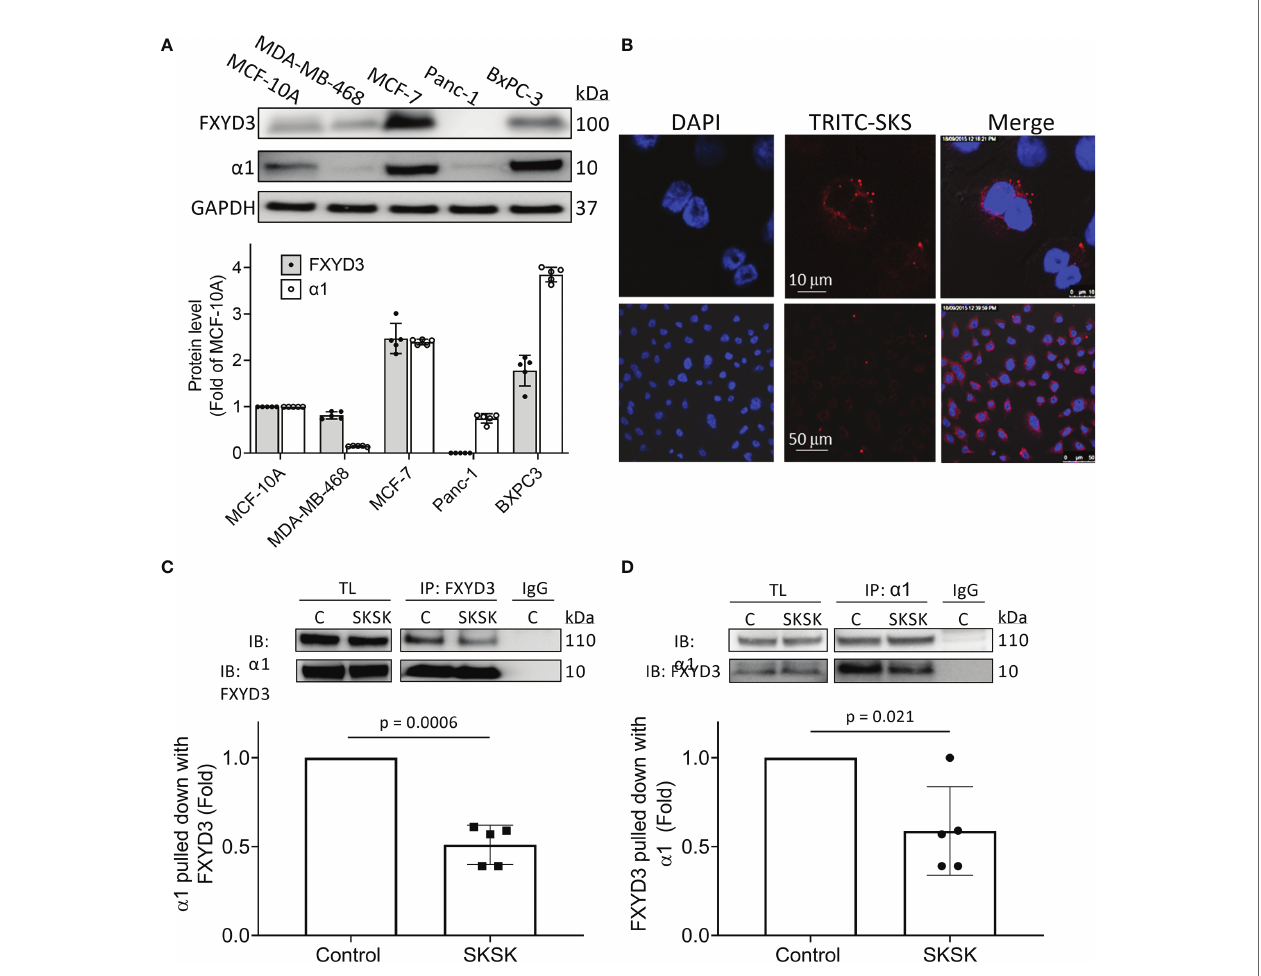
FIGURE 3 | Distribution of FXYD3-pep SKSK and its ability to displace FXYD3 from the a 1 Na + /K + -ATPase subunit. (A) FXYD3 and Na + /K + -ATPase a 1 subunit expression in MCF-7 and MDA-MB-468 breast cancer cells and in BxPC-3 and Panc-1 pancreatic cancer cells. Expression is normalized to expression in human non-cancer MCF-10A cells; GAPDH was the internal loading control. (B) Immuno fl uorescence showing distribution of TRITC-labeled FXYD3-pep SKSK in BxPC-3 cells. Cells were exposed to 1 µM TRITC-tagged FXYD3-pep SKSK (TRITC-SKSK) (red) for 2 h and fl uorescence microscopy performed 24 h after the peptide was washed off. DAPI was used to counterstain the nucleus (blue). One of 5 similar experiments is shown. Fluorescence is predominantly peri-nuclear. Scales are shown in the middle panel. (C) Immunoblot (IB) of a 1 Na + /K + -ATPase subunit with WT FXYD3 immunoprecipitant in lysate of BXPC-3 with and without exposure of the cells to 1 m M FXYD3-pep SKSK for 2 h before lysis. (D) Immunoblot of WT FXYD3 with the a 1 subunit immunoprecipitant in the lysate from the cells. C, control; TL, total lysate; non-immune IgG (IgG), negative control for IP. The ef fi ciency of the Co-Ip can be estimated by the comparison of b 1 subunit expression in the initial total lysate and the unbound supernatant after IP in BxPC-3 cells (data not shown). Approximate binding ef fi ciency was